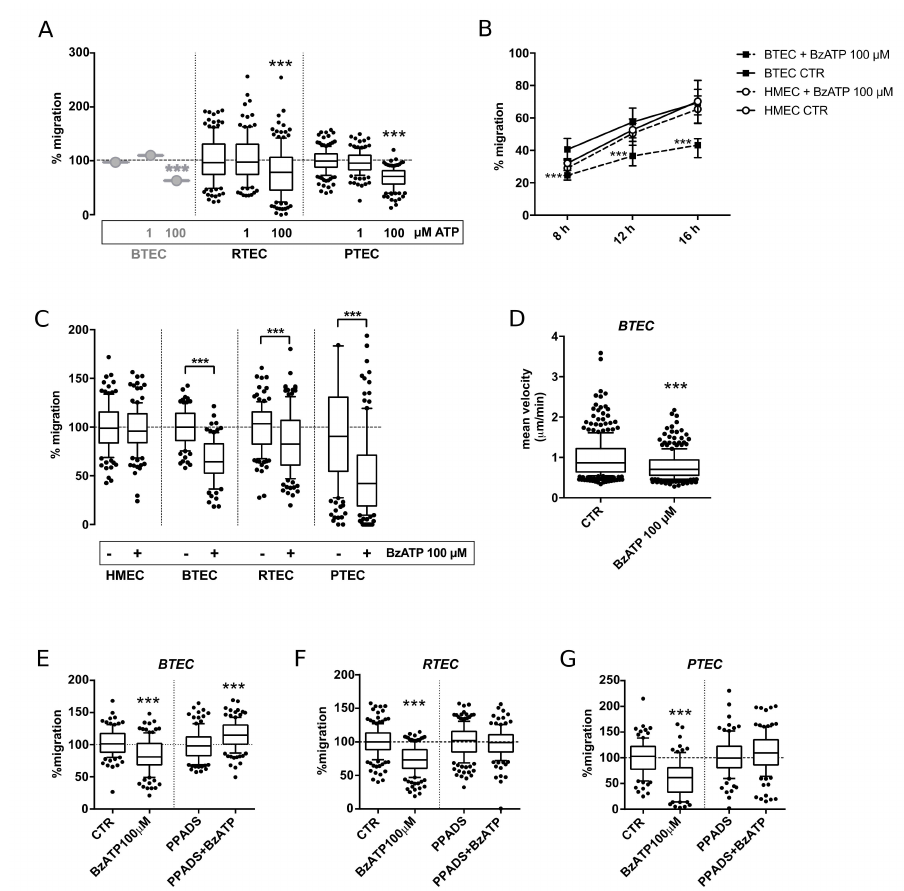
Figure 1. High concentrations of ATP or BzATP inhibited wound healing of TEC obtained from breast, renal and prostate carcinomas (respectively BTEC, RTEC and PTEC). ( A ) Effect of 1 µ M and 100 µ M ATP on wound healing in all 3 TEC types. ( B ) Representative wound healing